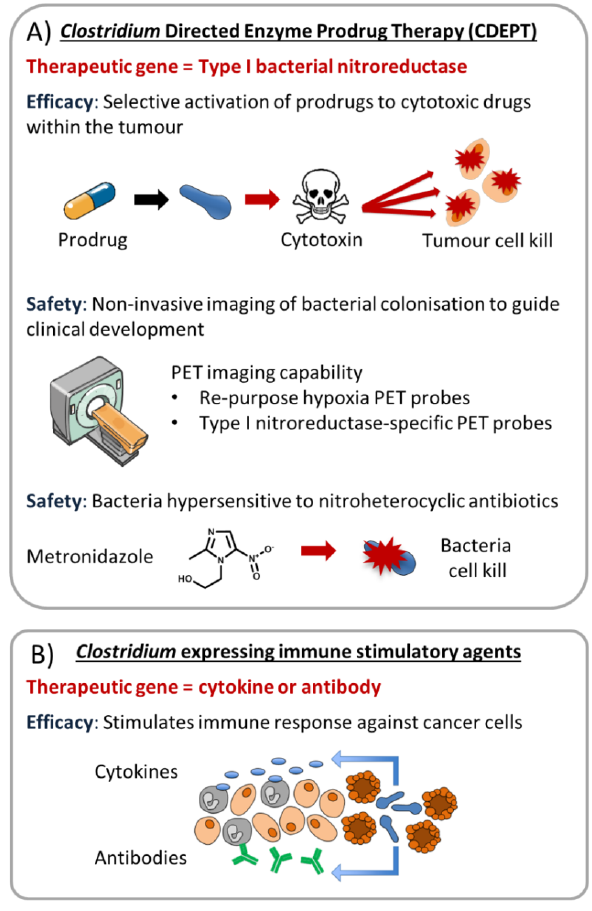
Figure 3. Expression of therapeutic transgenes confers new properties to the bacteria. ( A ) Use of a Type I bacterial nitroreductase has the potential to provide multi-functional features including conditional cytotoxicity, positron emission tomography (PET) imaging capability, and antibiotic hypersensitivity, as discussed previously by Williams and colleagues [60]; ( B ) Use of antibody or cytokine expression to target the tumour microenvironment.